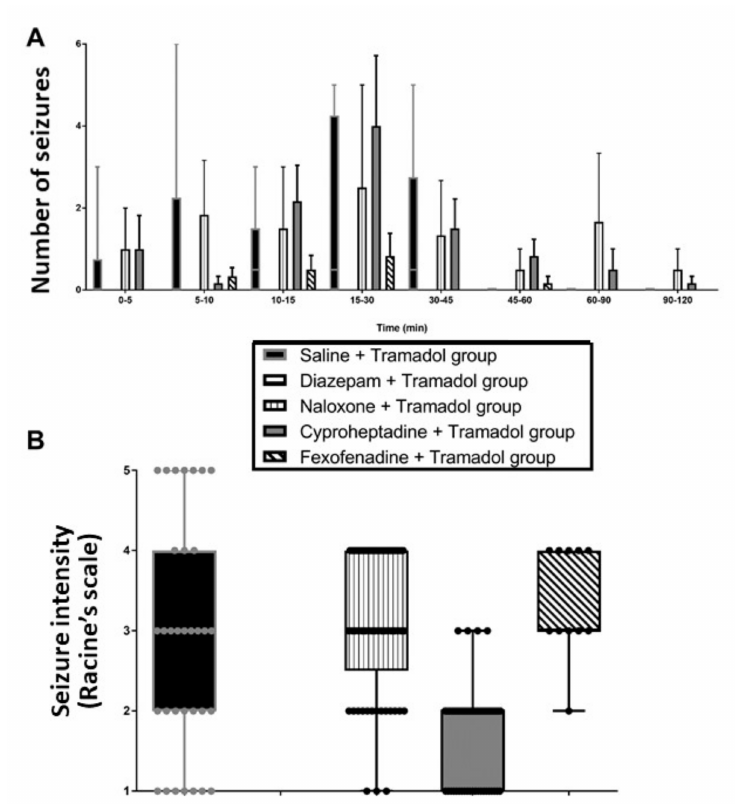
Figure 2. Effects on the seizure time-course ( A ) and intensity (( B ); each dot representing one seizure episode) of intraperitoneal (i.p.) 75 mg/kg tramadol administration in Sprague-Dawley rats pre- treated with i.p. 4% tween at T-15 + intravenous (i.v.) saline at T-10 (Saline + Tramadol group, black); i.p. 1.77 mg/kg diazepam at T-15 + i.v. saline at T-10 (Diazepam + Tramadol group, hori- zontal lines); i.p. 4% tween at T-15 + i.v. 2 mg/kg bolus followed by 4 mg/kg/h naloxone at T-10 (Naloxone + Tramadol group, vertical lines); i.p. 10 mg/kg cyproheptadine at T-15 + i.v. saline at T-10 (Cyproheptadine + Tramadol group, grey); and i.p. 15 mg/kg fexofenadine at T-30 + i.v. saline at T-10 (Fexofenadine + Tramadol group, diagonal lines). Results are expressed as median and quartiles. (N =